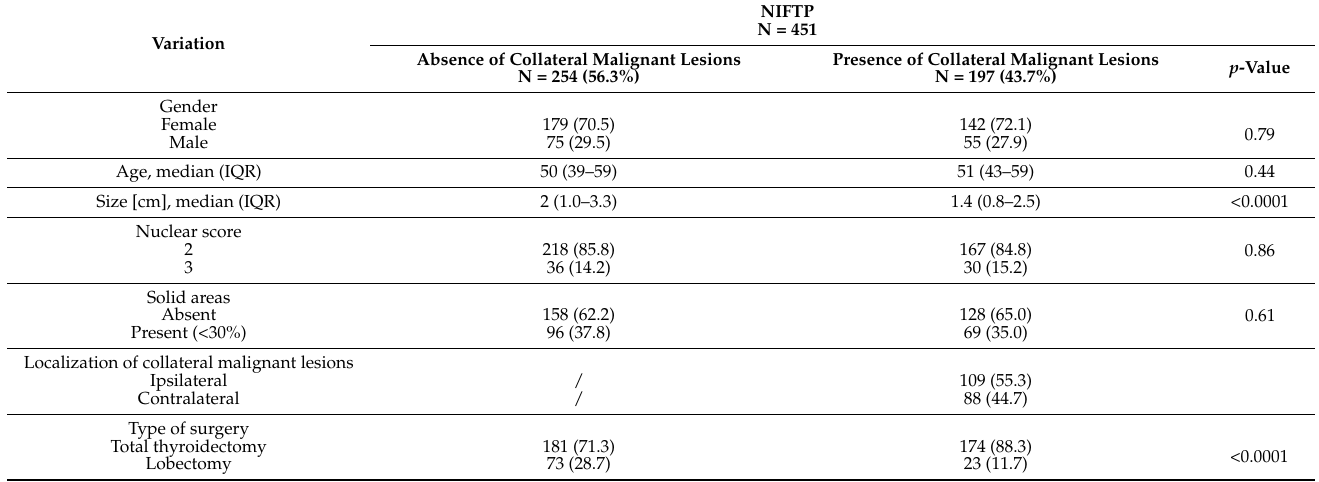
Table 2. Characteristics of NIFTP with and without collateral malignant lesions.